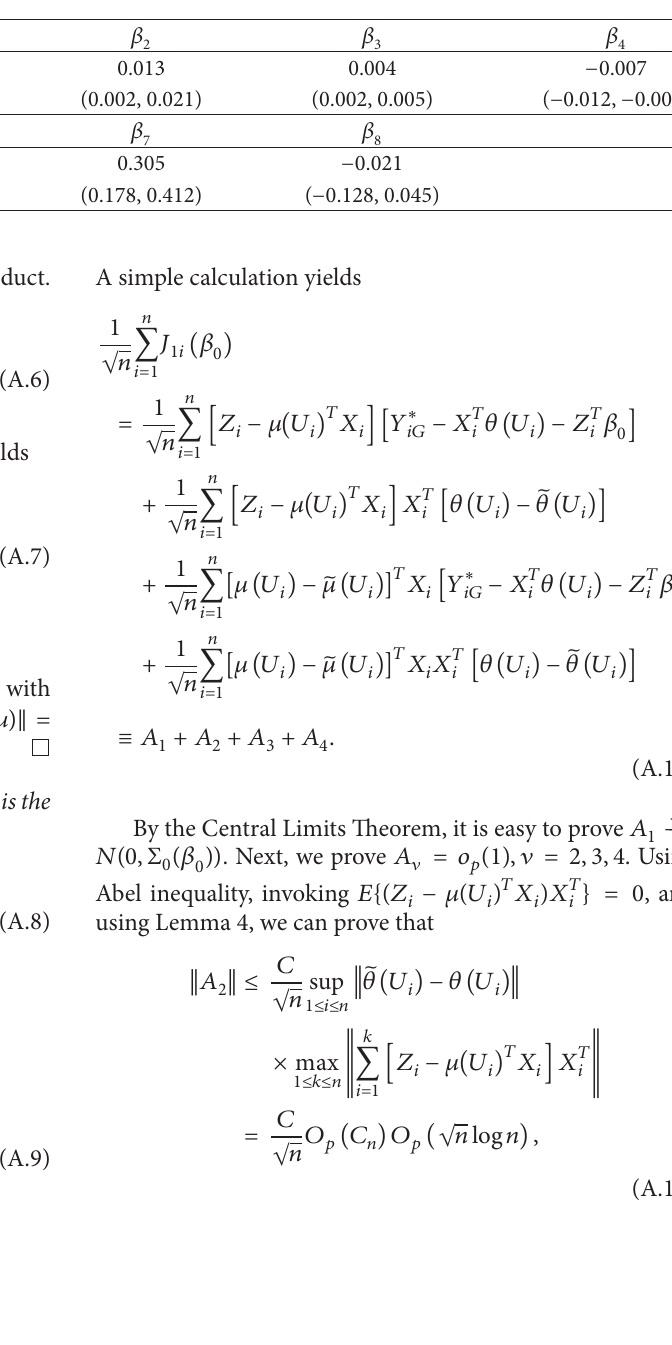
con�dence intervals for based on the AEL method and the NA method. Con�dence interval Length Coverage % 𝛽𝛽